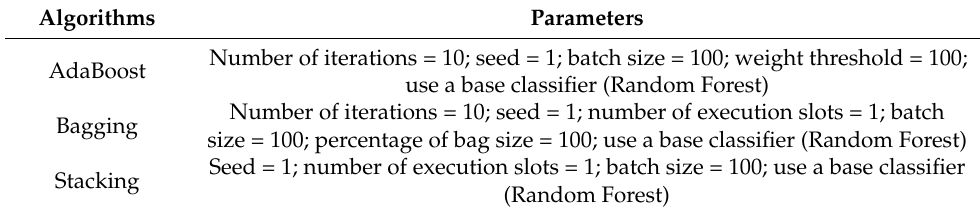
Table 4. Parameters used by ensemble